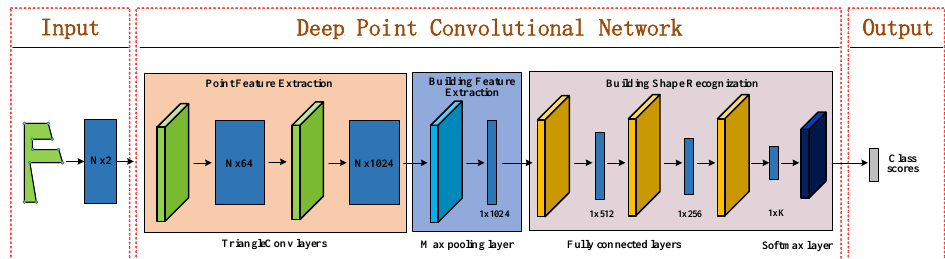
Figure 1. The framework of DPCN. The left-most side indicates that the input of DPCN is a list of points with the coordinates as their initial features. The middle part is the network used by DPCN to learn the feature representations of the input buildings and predict their classes. The right-most part shows the output of DPCN, which is a score vector of which each dimension means the possibility that the input building belongs to a certain shape